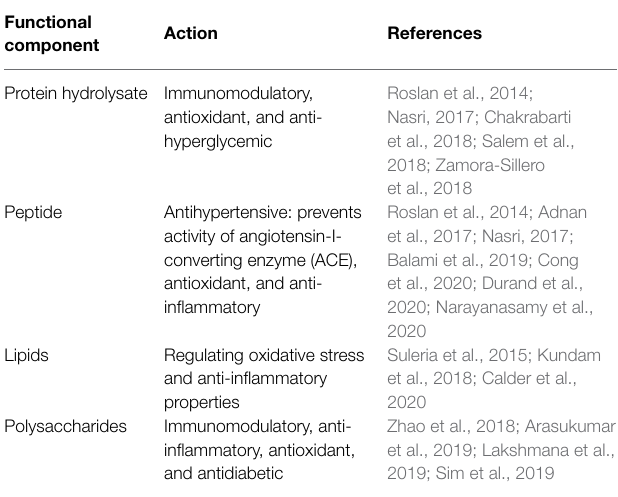
TABLE 1 | Impact of aquatic-based functional foods on immune system/ COVID-19. Functional